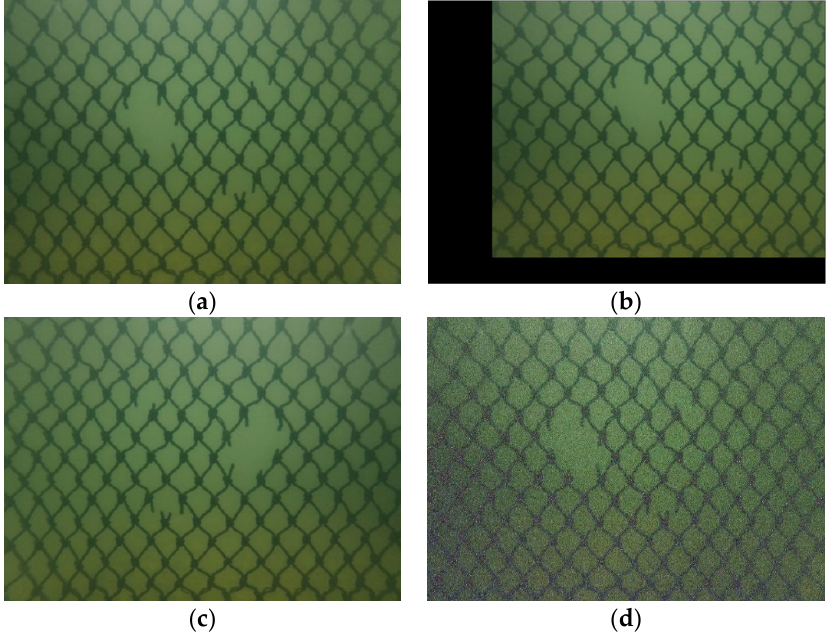
Figure 2. Augmentation operations on the damaged netting images. ( a ) Original image. ( b ) Trans- lation operation. ( c ) Mirror operation. ( d ) Gaussian noise.